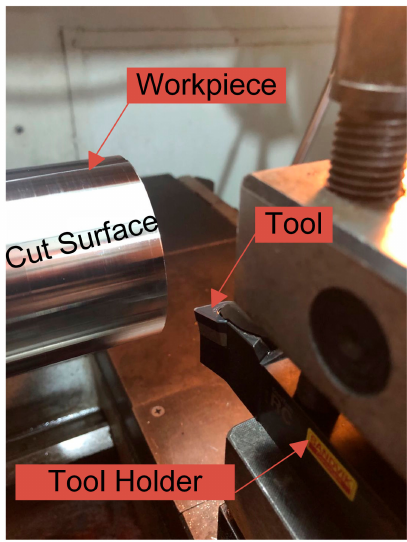
Figure 5. Details of the turning